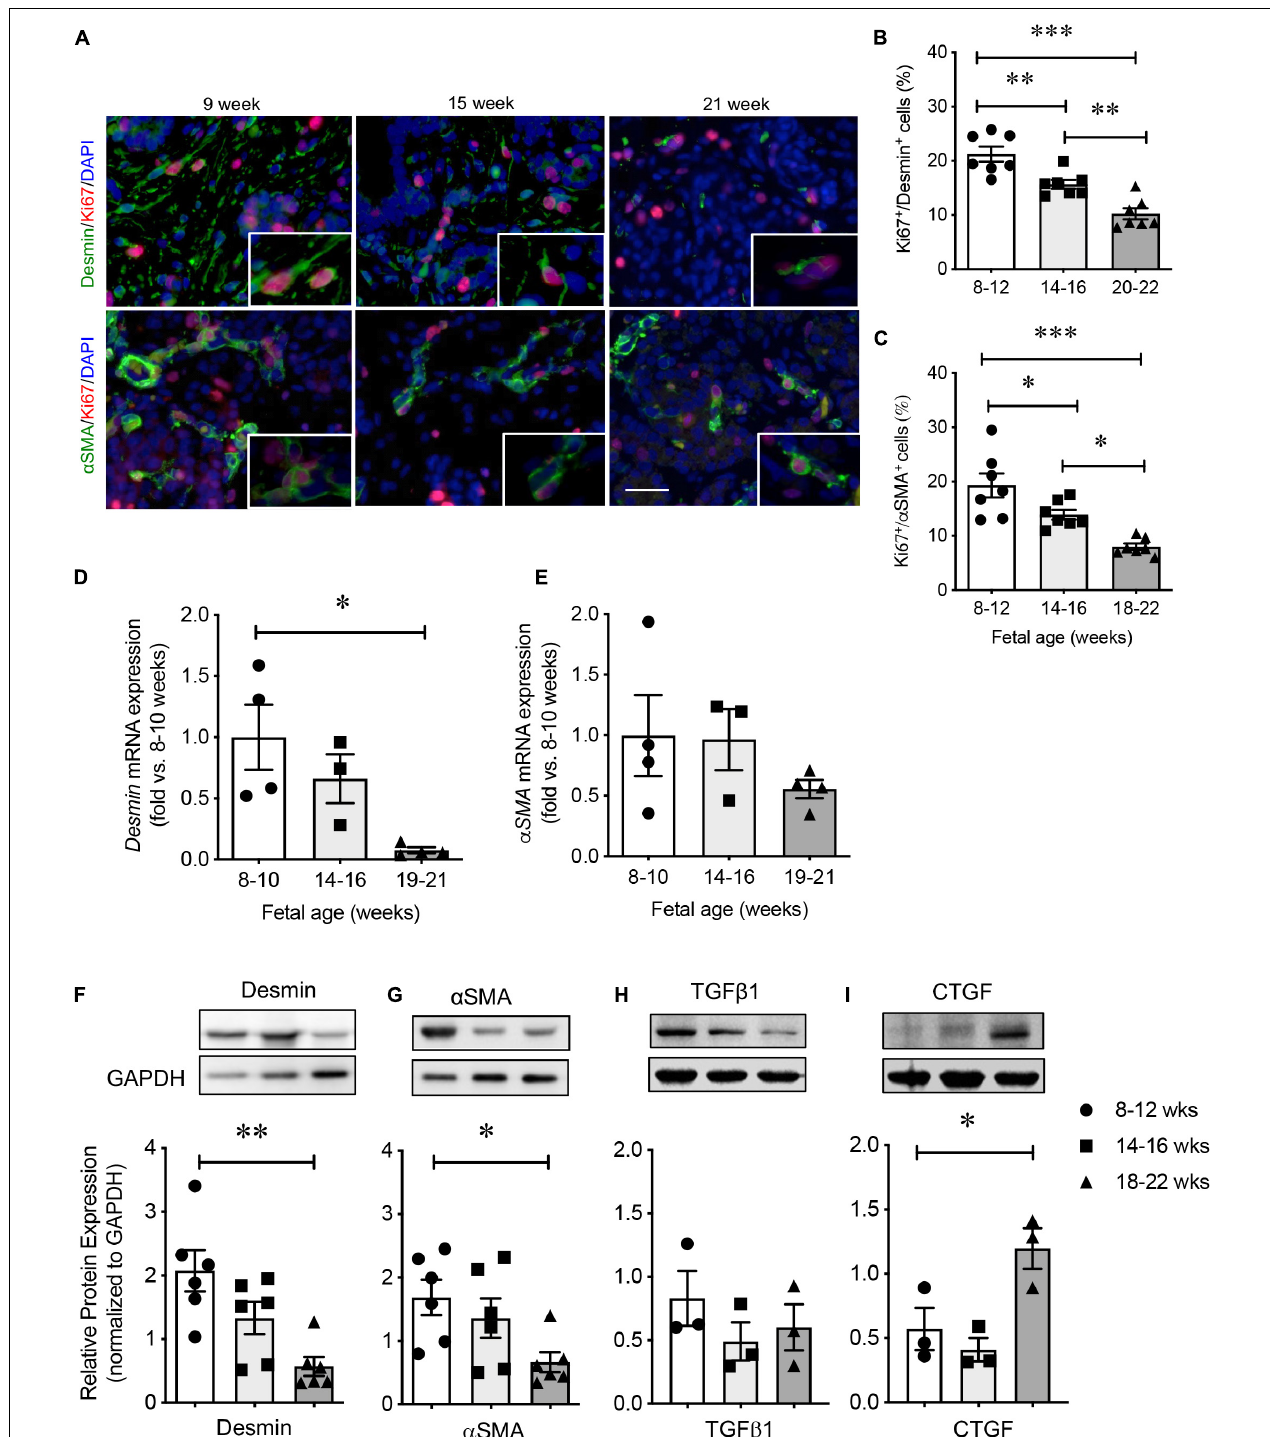
FIGURE 3 | Characterization of PaSCs in the developing human fetal pancreas. (A) Representative double immunofluorescence staining images for desmin or α SMA (green) with Ki67 (red) and the nuclear stain DAPI (blue) in the human fetal pancreas. Scale bar: 25 µ m. Magnified images are shown in insets. Quantification of proliferative PaSCs with Ki67 + /desmin + (B) or Ki67 + / α SMA + (C) in the developing human pancreas. qRT-PCR analysis of PaSC-related genes (D) desmin and (E) α SMA. Western blot analysis of proteins (F) desmin, (G) α SMA, (H) TGF β 1, and (I) CTGF. Closed circles, 8–12 weeks; closed squares, 14–16 weeks; closed triangles, 18–22 weeks. Data are expressed as mean ± SEM ( n = 3–7 pancreata/age group). ∗ p < 0.05, ∗∗ p < 0.01, ∗∗∗ p < 0.001; analyzed using one-way ANOVA with Tukey’s post hoc test.